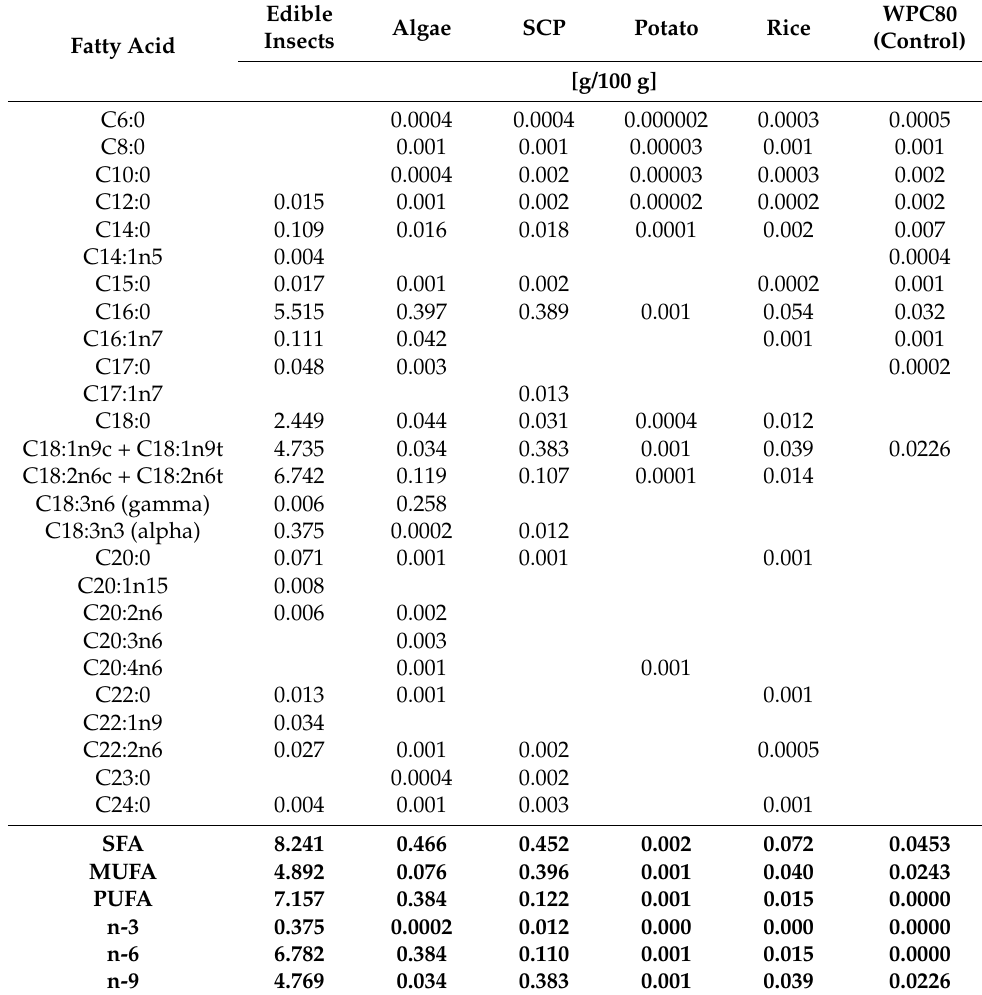
Table 3. Fatty acid composition of alternative and unconventional protein sources compared to the whey protein concentrate (WPC80—control